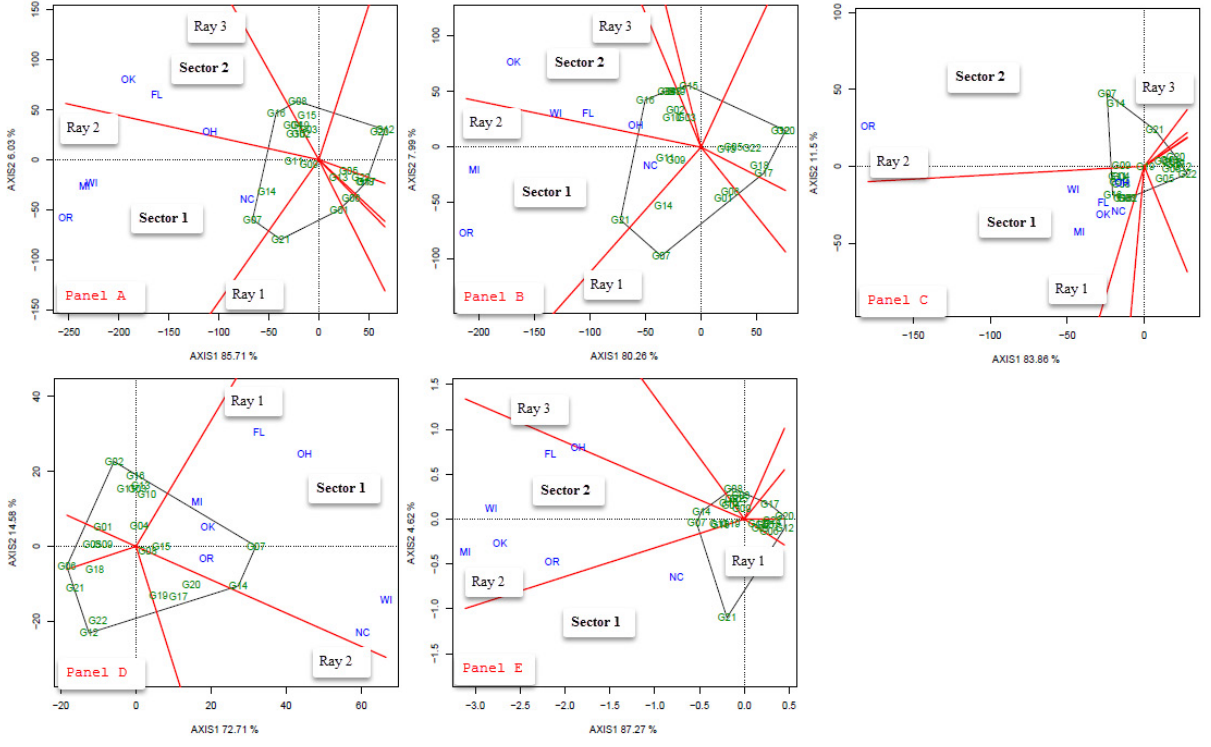
‘mean vs. stability’ view of GGE biplot explained 92%, 88%, 95%, 87% and 92% of the genotype and genotype x environment variation for the total yield, marketable yield, early yield, percent cull and fruit plant -1 , respectively (Figure 3: Panel A, B, C, D and E). The arrow shown on the AEC abscissa points in the direction of higher trait performance of genotypes and ranks the genotypes with respect to trait performance. Thus, genotype ‘Colet F1’ (G07) had the highest total yield and ‘Ark. Littleleaf’ (G12) had the lowest (Figure 3: Panel A). Similarly, WI 5096 (G21), ‘Regal F1’ (G16), and ‘Colet F1’ (G07) had the highest marketable yield, early yield, and percent cull and fruit per plant, respectively. ‘Ark. Littleleaf’ (G12), WI 2757 (G20), ‘Wautoma F1’ (G22), ‘Clinton’ (G06), and WI 2757 (G20) and ‘Ark. Littleleaf’ (G12) had the lowest total yield, marketable yield, early yield, percent cull and fruit per plant, respectively (Figure 3: Panel A, B, C, D and E). The stability of each genotype was explored by its projection onto the AEC vertical axis. The most stable genotype was located almost on the AEC abscissa (horizontal axis) and